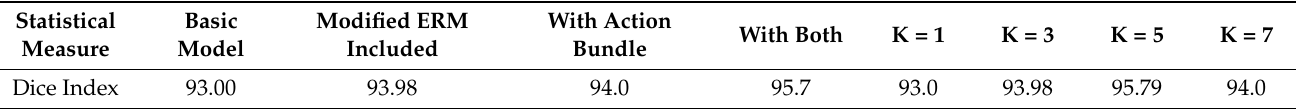
Table 1. The Dice index values taken for the ablation experiments. The various values of K are the different settings for the action bundle.